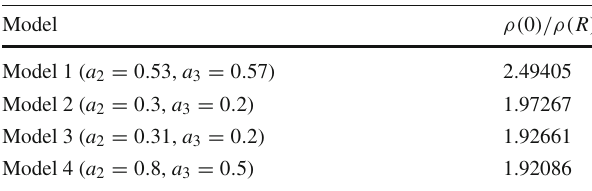
Table 3 Estimated values of the density ratio for Cen X-3 (u =